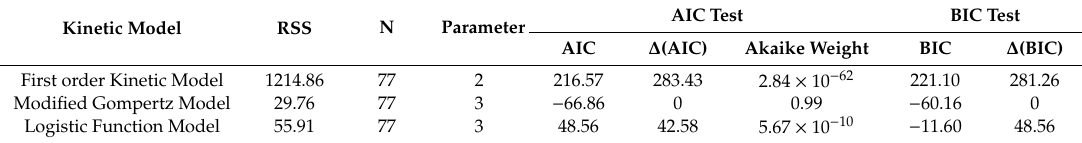
Table 6. Criteria for analysis of the best fit of the three kinetic